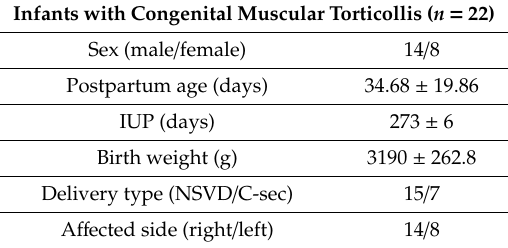
Table 1. Patient